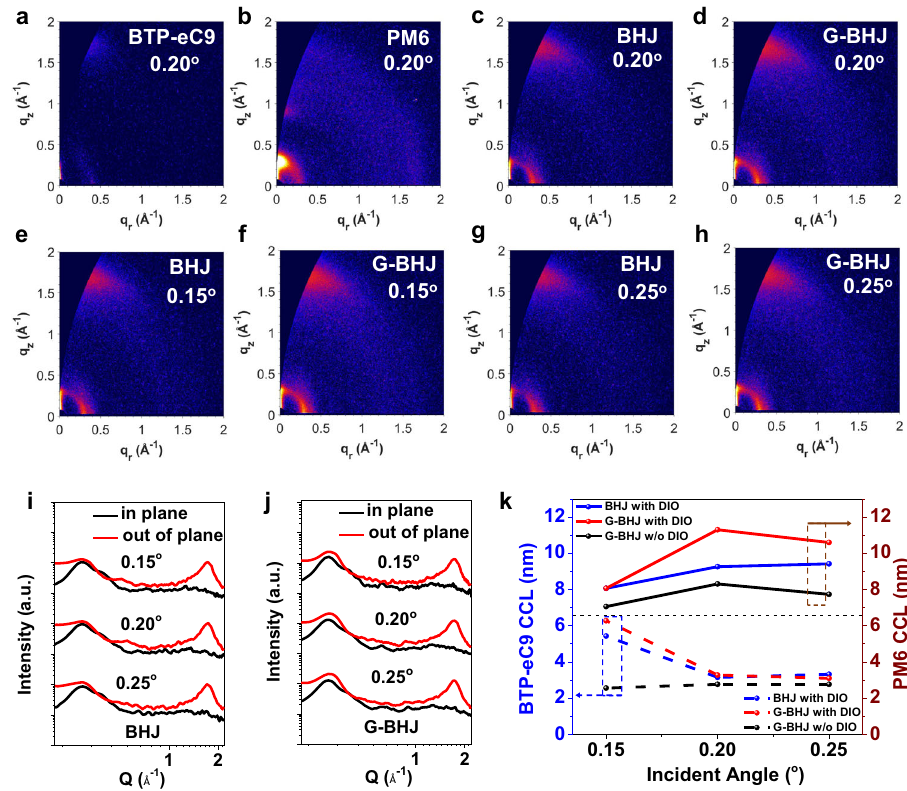
Fig. 3 Molecular packing and crystallinity of BHJ and G-BHJ fi lms. 2D GIWAXS patterns of a neat BTP-eC9 fi lm, b neat PM6 fi lm, c the optimal BHJ and d the optimal G-BHJ processed fi lms at critical incident angle of 0.20°. 2D GIWAXS patterns of e the optimal BHJ and f the optimal G-BHJ fi lms collected at incident angles of 0.15°. 2D GIWAXS patterns of g the optimal BHJ and h the optimal G-BHJ fi lms collected at incident angles of 0.25°. The corresponding 1D linecut pro fi les of i the optimal BHJ and j the optimal G-BHJ fi lms at three different X-ray incident angles of 0.15°, 0.20° and 0.25°, respectively. k Coherence lengths of PM6 and BTP-eC9 in three fi lms versus varied incident